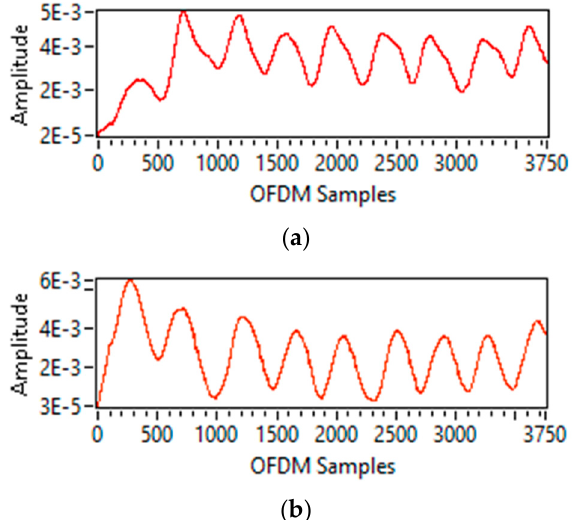
Figure 8. Breathing patterns detection for two-person and three persons-scenarios: ( a ) two persons- scenario (normal-slow); and ( b ) three persons scenario (normal-normal-normal).